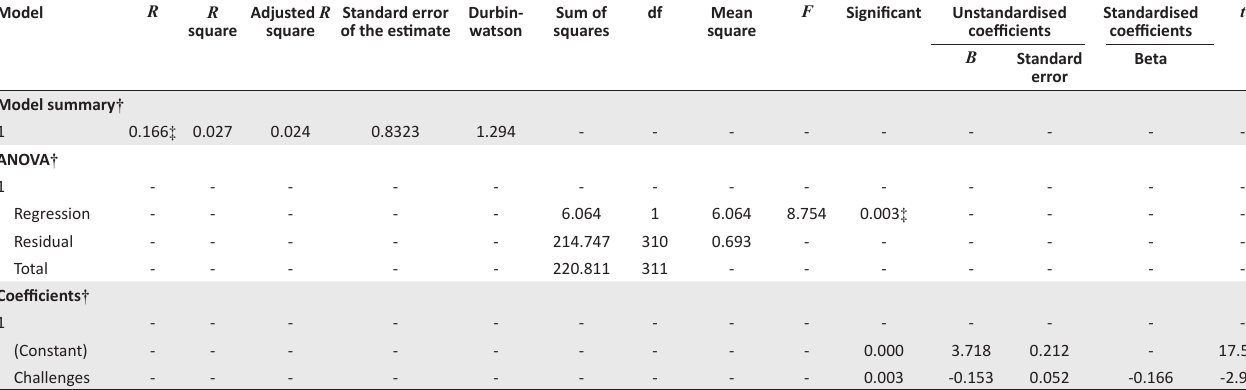
TABLE 5: Regression analysis: Challenges and digital human resource management practices. Model